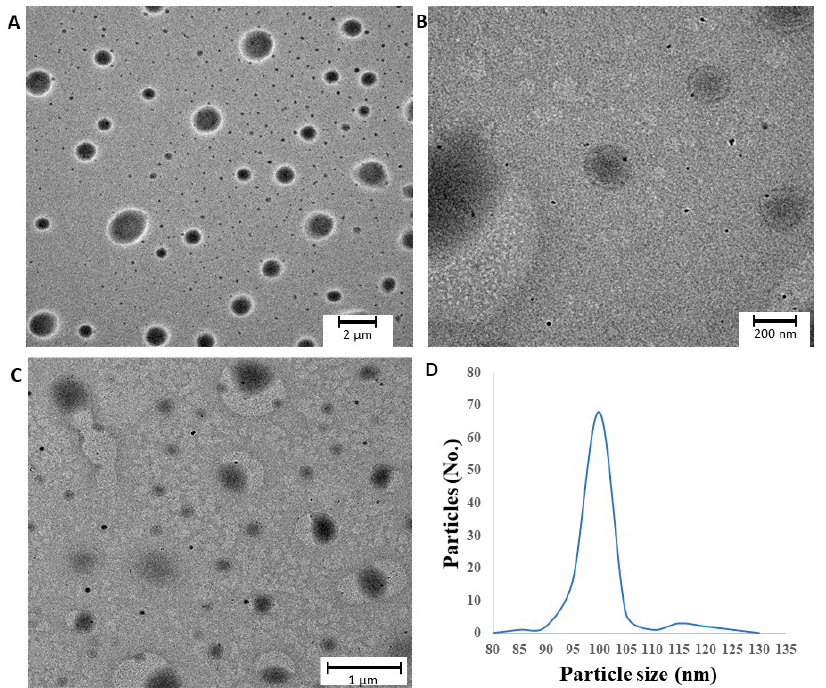
Figure 4. ( A – C ) TEM images of optimized freeze-dried MEL-loaded polymeric micelles and ( D ) particle size distribution.